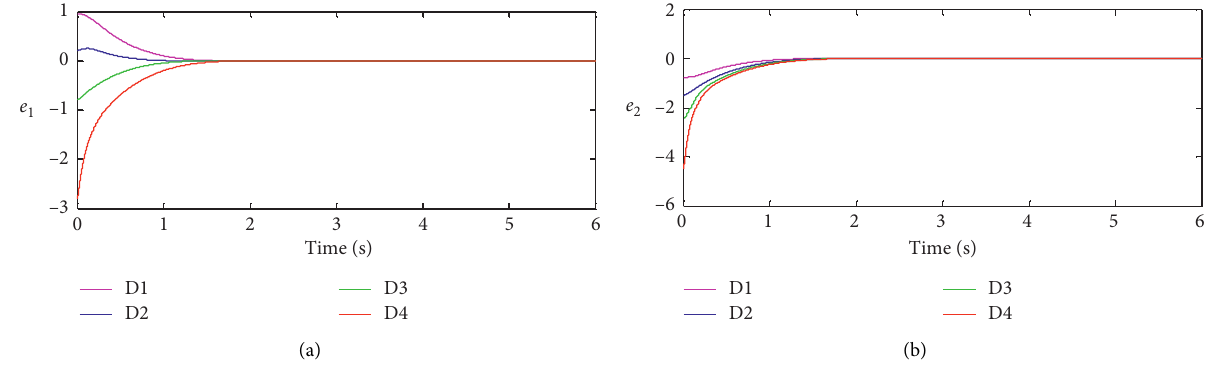
Figure 6: Position tracking errors with different desired